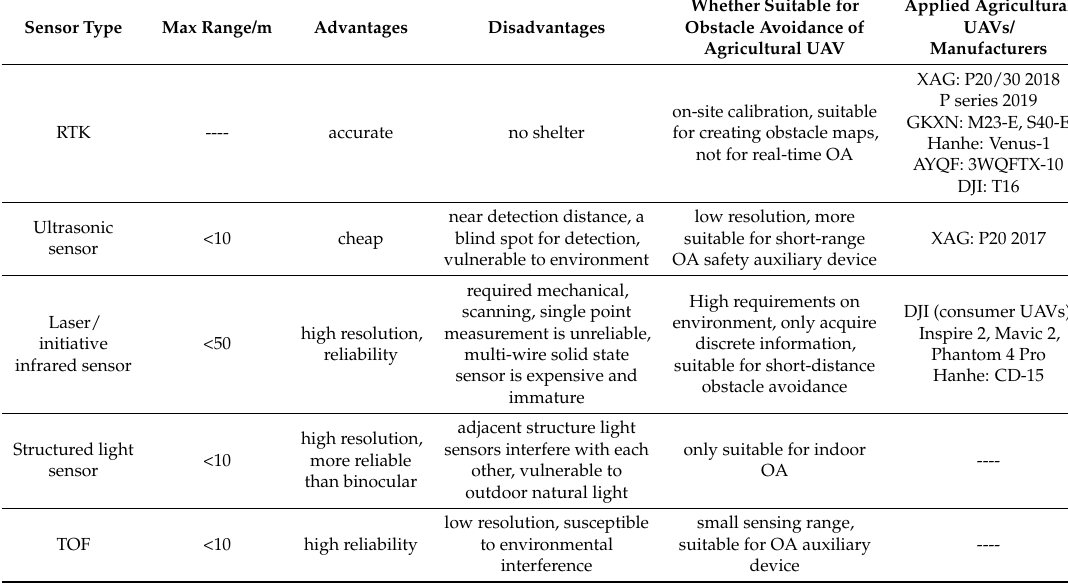
Table 1. Comparison of Various Obstacle Avoidance